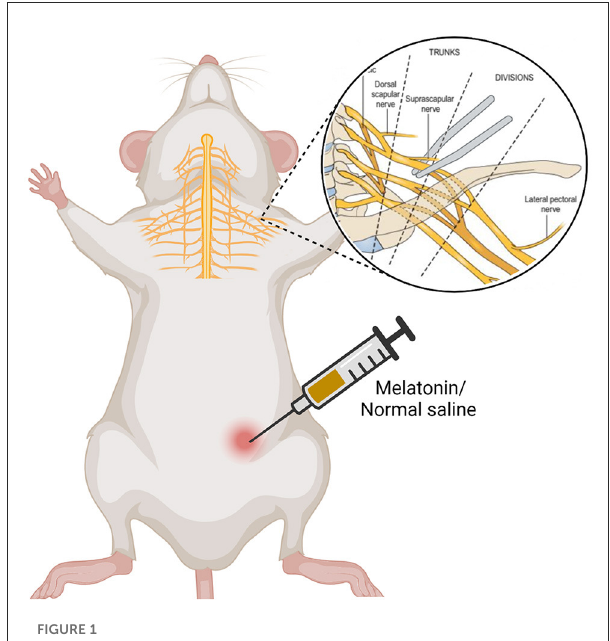
FIGURE1 The modeling diagram.